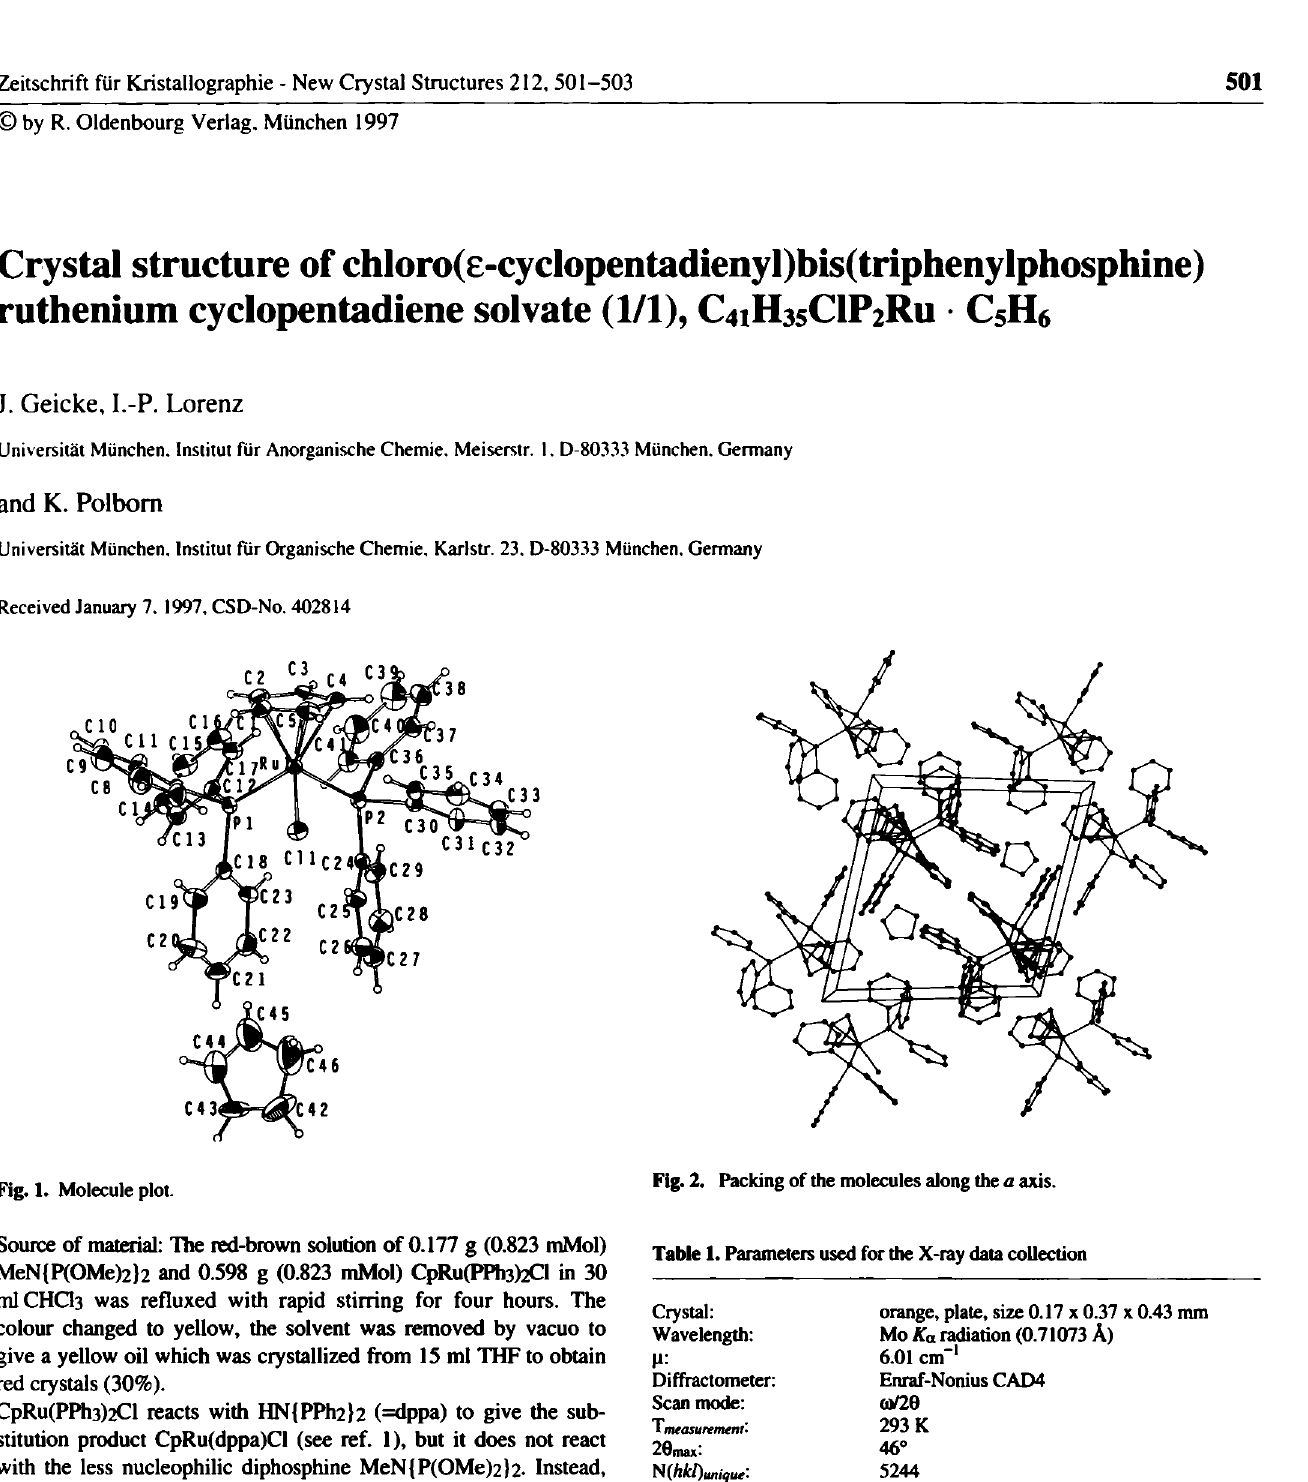
Table 2. Final atomic coordinates and displacement parameters (in Â 2